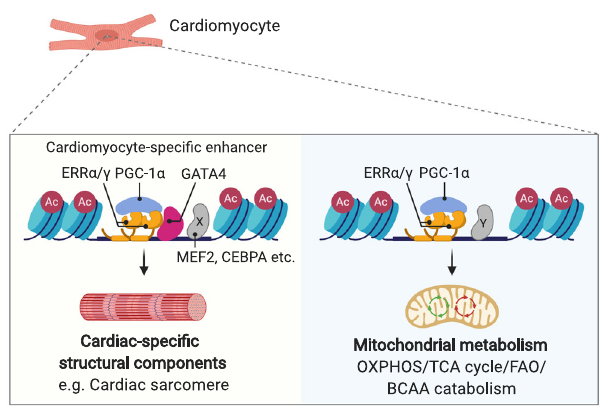
Fig. 8 Proposed model for coordinate transcriptional control of cardiac energy production and cardiac-speci fi c processes such as the sarcomere by ERR γ . The fi gure was created with